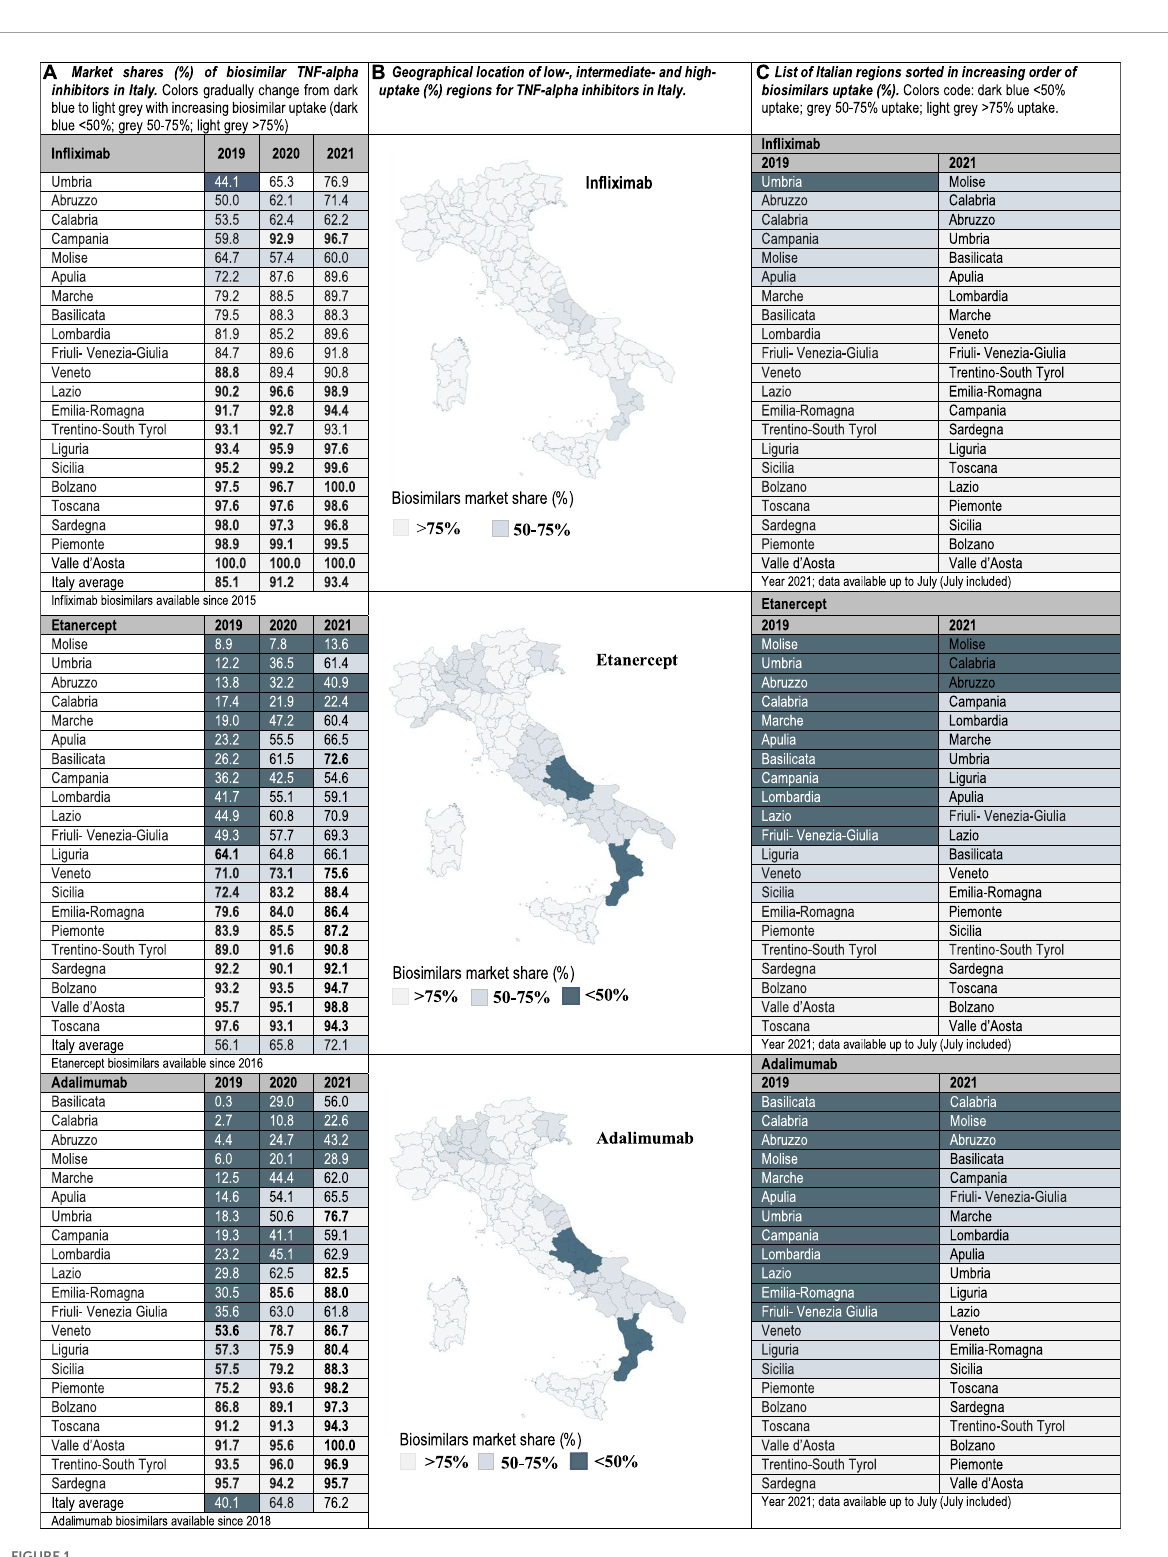
FIGURE1 (A) Market shares (%) of biosimilar TNF-alpha inhibitors in Italy. Data at the national/regional level are provided for infliximab, etanercept, and adalimumab biosimilars (2019–2021). Regional uptake data were only publicly available since 2019. (B) Geographical location of low-( < 50%), intermediate-(50–75%), and high-uptake ( > 75%) regions for TNF-alpha inhibitors in Italy. (C) List of Italian regions sorted in increasing order of biosimilars uptake